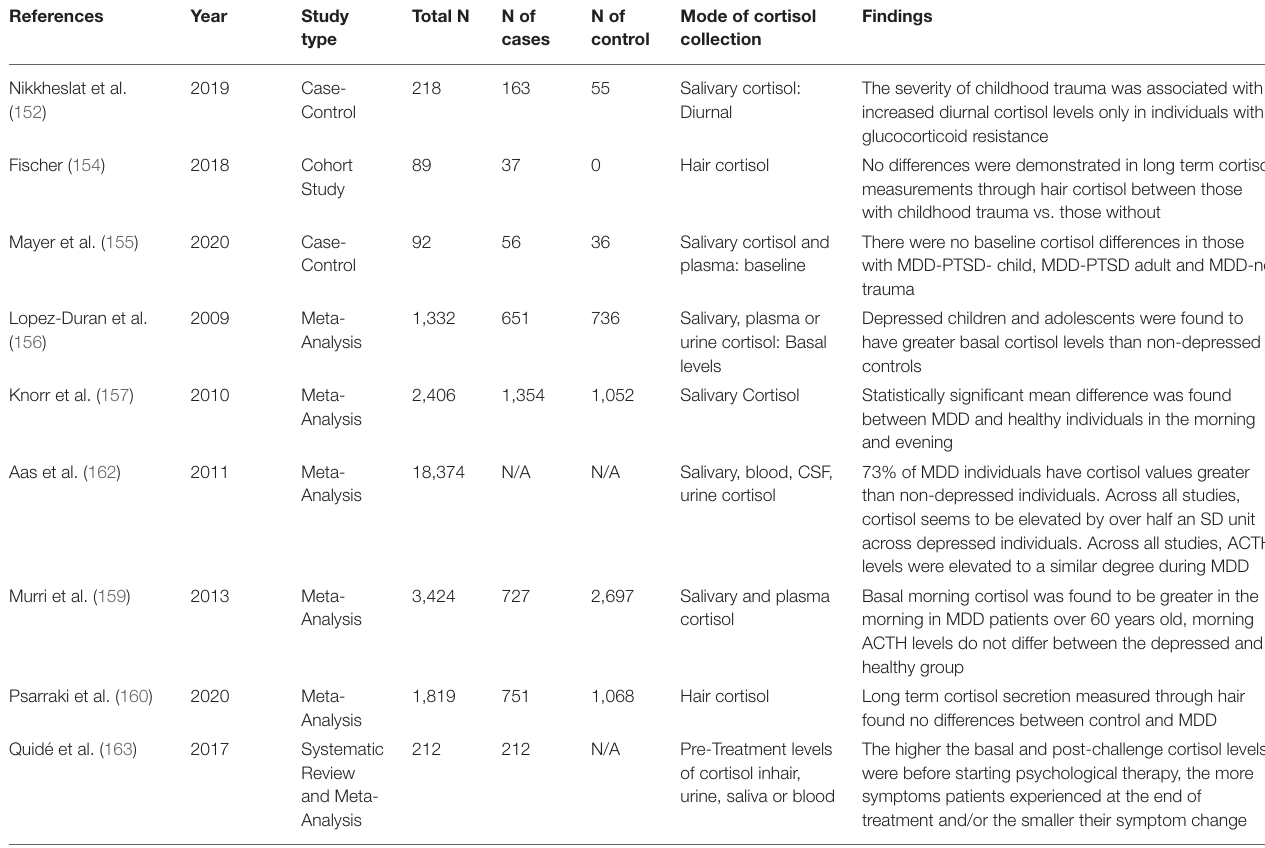
TABLE 1 | Daily HPA measurements in